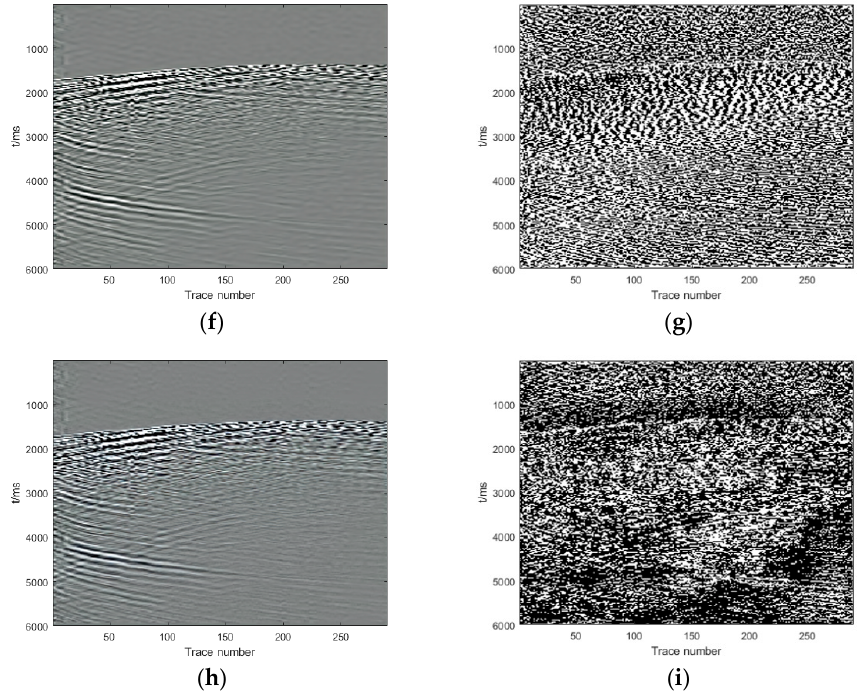
Figure 12. Denoising results of the third field example. ( a ) Noisy data; ( b ) Denoised image through the pre-trained model; ( c ) The difference profiles between noisy data ( a ) and pre-denoised data ( b ); ( d ) Denoised data through the proposed method; ( e ) The difference profiles between noisy data ( a ) and denoised data ( d ); ( f ) Denoised data through the DnCNN; ( g ) The difference profiles between noisy data ( a ) and denoised data ( f ); ( h ) Denoised data through the U-net; ( i ) The difference profiles between noisy data ( a ) and denoised data ( h ).